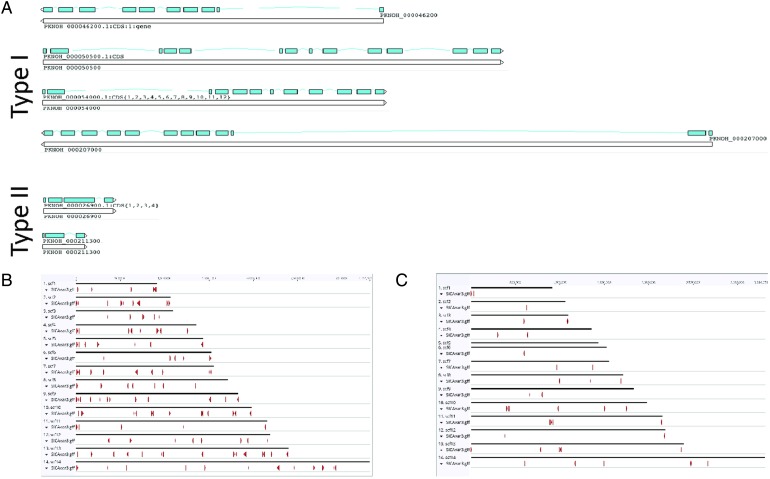
SICAvar distribution and gene models. (A) Shown are representative examples of
types I and II SICAvar genes with exons noted in blue, and their directionality
indicated with arrow heads placed at the end of the 3-prime exons. Type I SICAvar
genes are characterized by multiple exons (5–16), often with extremely large
introns, particularly between exons 2 and 3. Type II SICAvar genes have three or
four exons and are more compact with smaller introns. In five of the six examples
shown, the initial two exons shown are typical. (B) Distribution of full SICAvar
genes (types I and II) along the PKNOH scaffolds. (C) Distribution of partial
SICAvar gene segments (types I and II) along the PKNOH scaffolds.